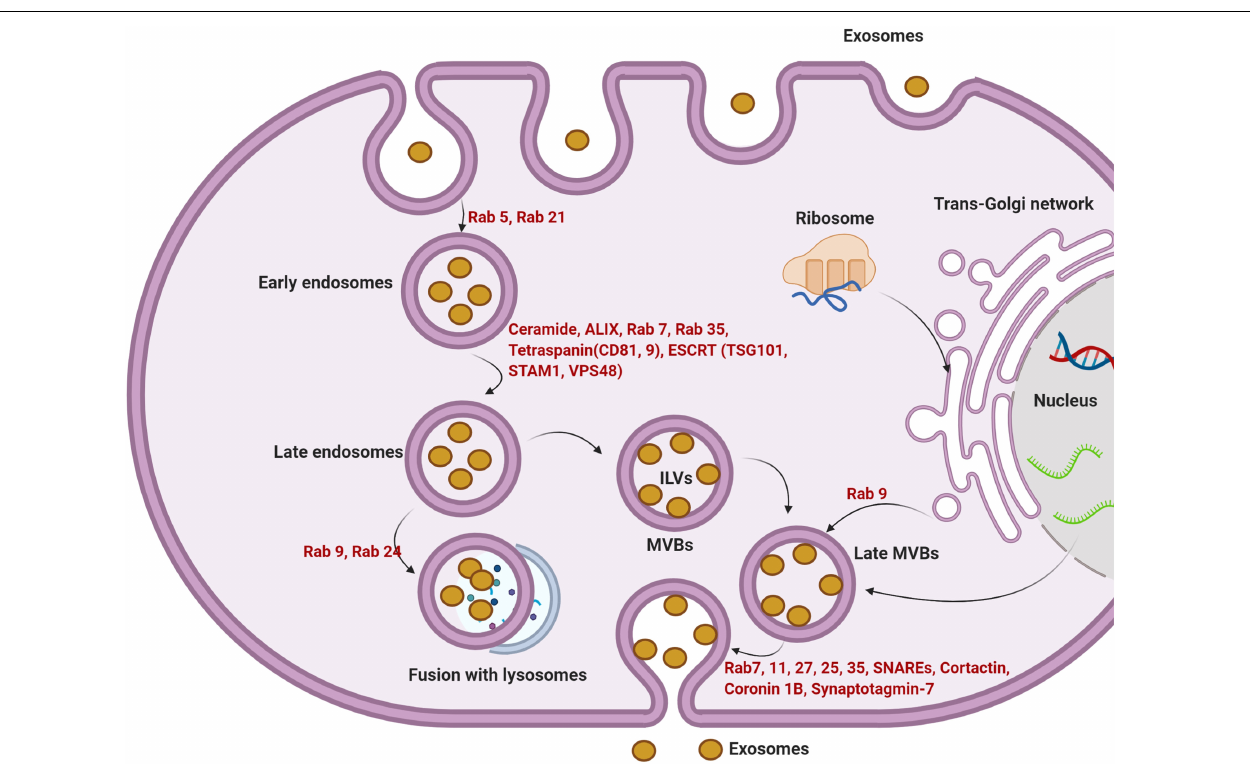
FIGURE 2 | The multi-step intracellular maturation of exosomes is illustrated. For the initial internalization via endocytosis, GTPases including Rab5 and Rab21 play a significant role in the formation of early endosomes. The formation of late endosomes is done via engaging other important factors such as ceramide, ALIX, Rab7, 35, tetraspanins, and ESCRT complex. Due to the activity of other Rab types (Rab9 and 24), later endosomes are directed to lysosomes. Alternatively, late endosomes become MVBs. The invagination of the MVBs membrane forms numerous ILVs. Upon the release of ILVs to the ECM, they are thereafter referred to as exosomes. Trans- Golgi apparatus further supports an alternative way to form MVBs by the activity of certain GTPases such as Rab9. The fusion of later MVBs to the cell membrane is mediated by different effectors including Rab7, 11, 27, 25, 37, SNAREs, and other elements. ILVs, intraluminal vesicles; MVBs, multivesicular bodies; ESCRT, endosomal sorting complex required for transport; SNARE, soluble N-ethylmaleimide-sensitive factor attachment protein